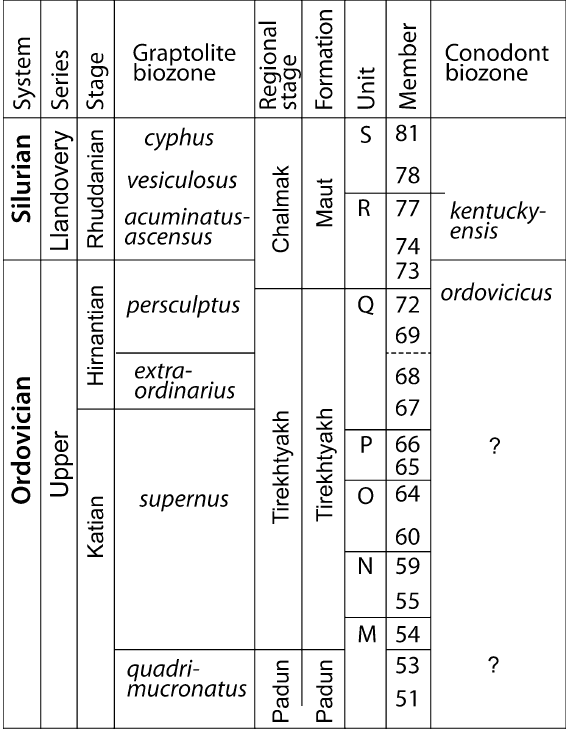
Fig. 2. Stratigraphy of the upper Ordovician and lowermost Silurian of the study area in NE Russia. The scheme is based on Koren ′ et al. (1983) with modifications according to Koren ′ & Sobolevskaya (2008) and Zhang & Barnes